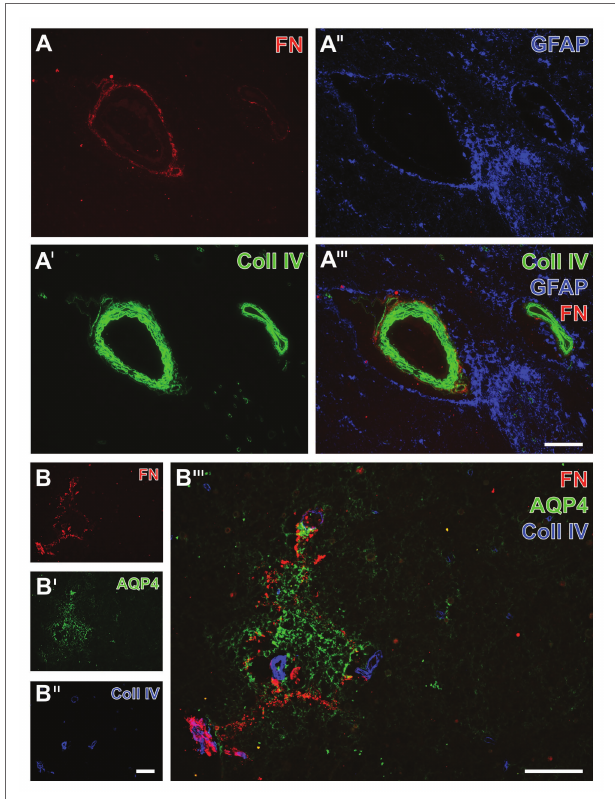
FIGURE 10 | Triple immunofluorescence labeling of fibronectin, collagen IV, and astrocytes in human autoptic tissue affected by a stroke with a post- ischemic period of 3 weeks. Staining of fibronectin (FN, A,B ) and collagen IV (Coll IV, A ' ,B '' ) combined with astroglial components, i.e., GFAP (A '' ) located in cell bodies and AQP4 typically located in astroglial endfeet (AQP4, B ' ), reveals a shell-like pattern of FN and Coll IV in the ischemia-affected brainstem, while the FN signal is encircling Coll IV as obvious at perpendicularly cut vessels (A ''' ) . In close vicinity to the vessels, diffusely labeled GFAP-containing astroglial structures are visible (A '' ,A ''' ) , not overlapping with FN or Coll IV. The AQP4 immunoreactivity appears in an inhomogeneous manner not following cellular compartments as a sign of significantly degenerated astroglial endfeet in close regional association to the ischemia-related increase of FN signal (B ''' ) . Scale bars: in A ''' (also valid for A , A ' , and A '' ) = 100 μ m, in B ''' = 100 μ m, in B '' (also valid for B and B '' ) = 100 μ